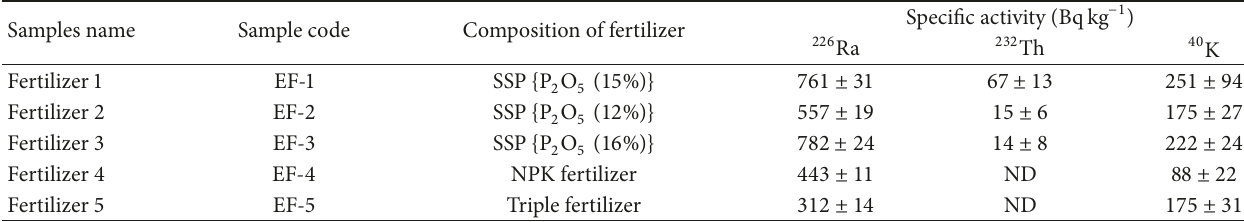
Table 1: Activity concentrations of 226 Ra, 232 Th, and 40 K in Egyptian fertilizers.